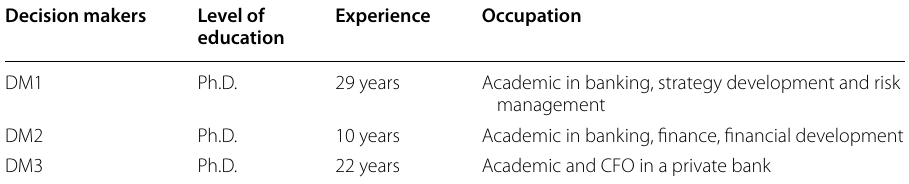
Table 3 The details decision makers